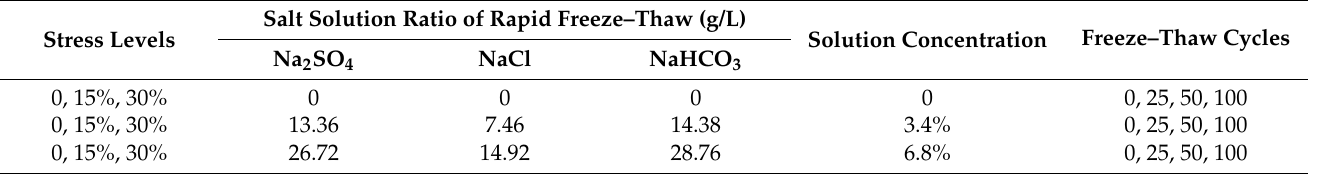
Table 2. Experimental scheme of freeze–thaw cycles in salt solutions. Stress